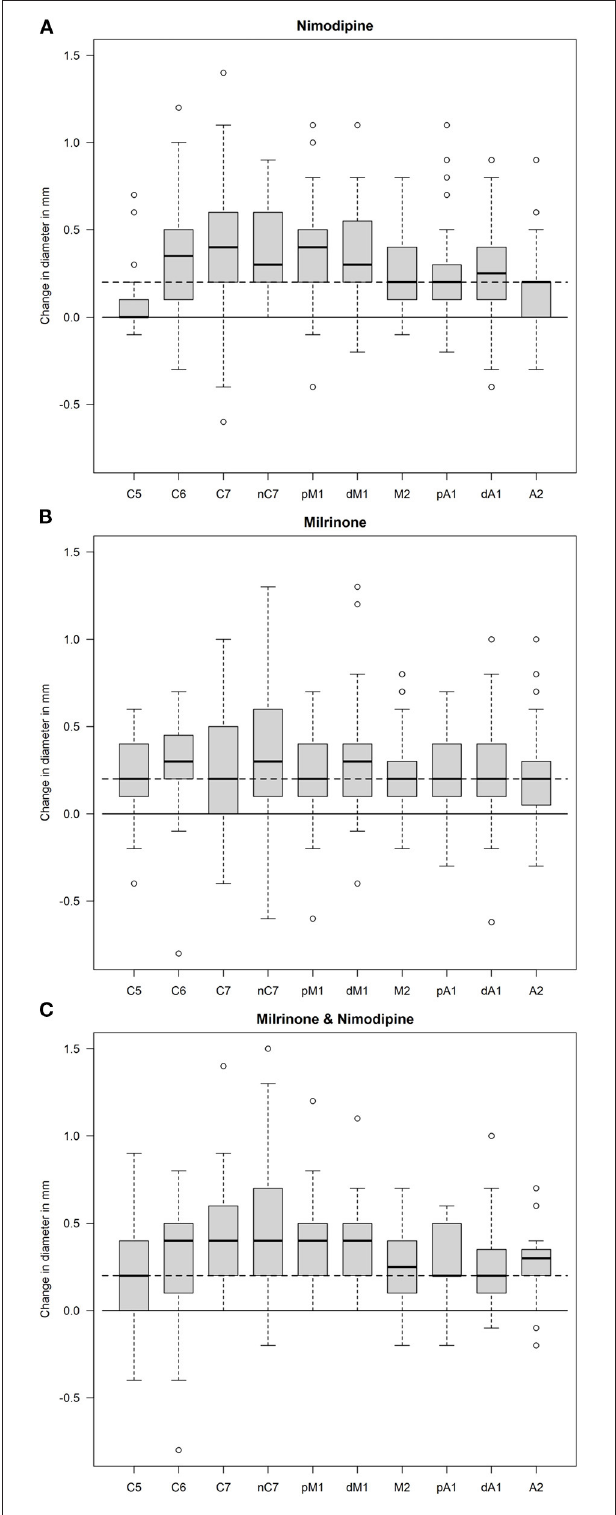
FIGURE 2 | Box plot of diameter differences. The difference in vessel diameters (in mm) under pharmacological spasmolysis is depicted for each